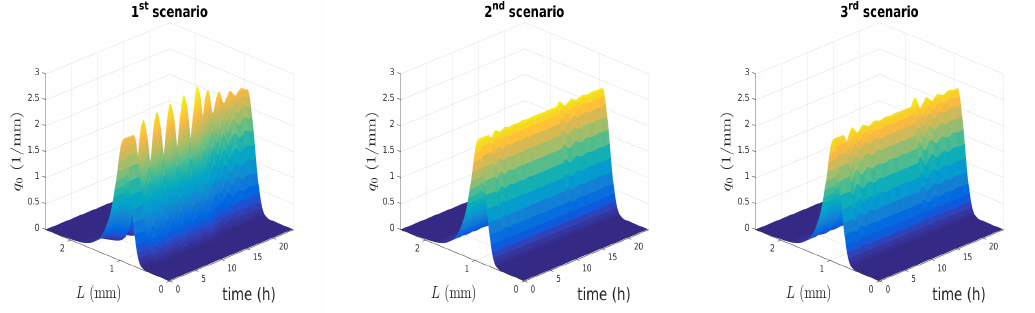
Figure 7. Normalized particle size distribution q 0 ( t , L ) related to the first, second, and third Processes 2018 , 6 , 235 simulation scenario.